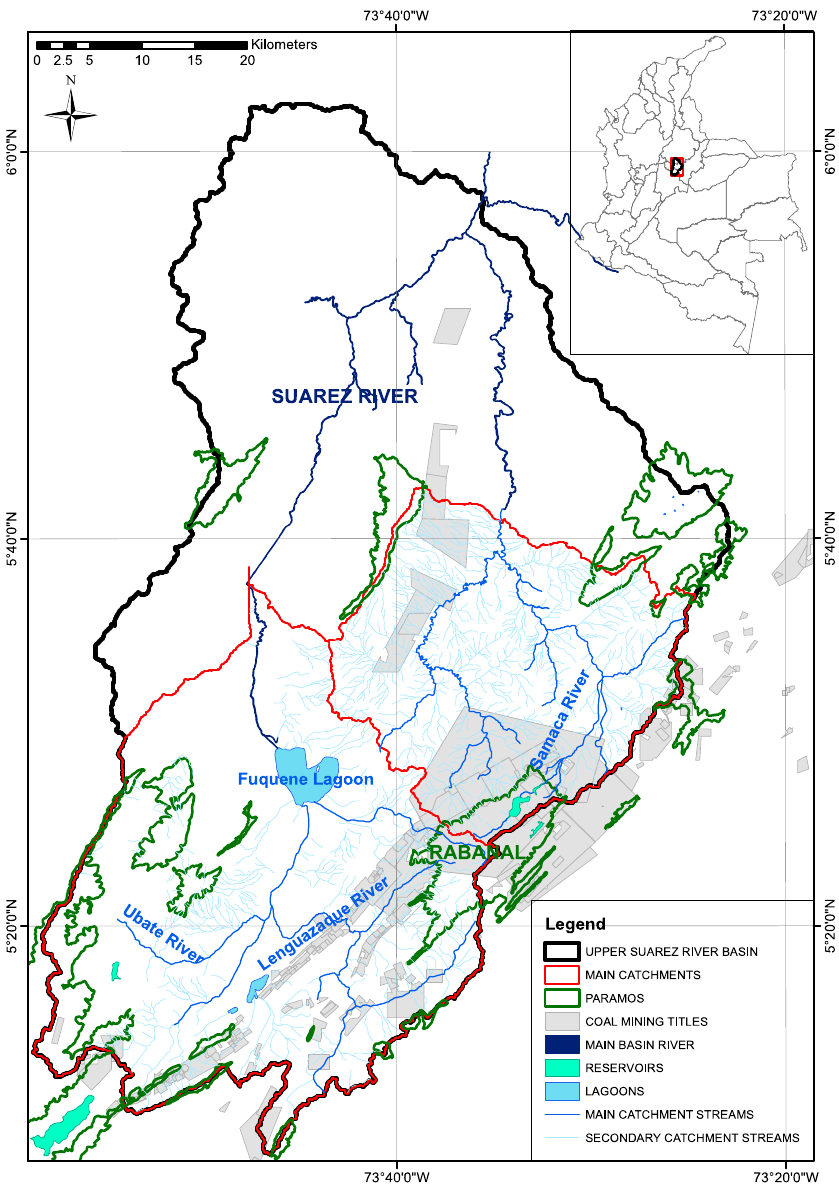
Figure 3. Case study catchments.